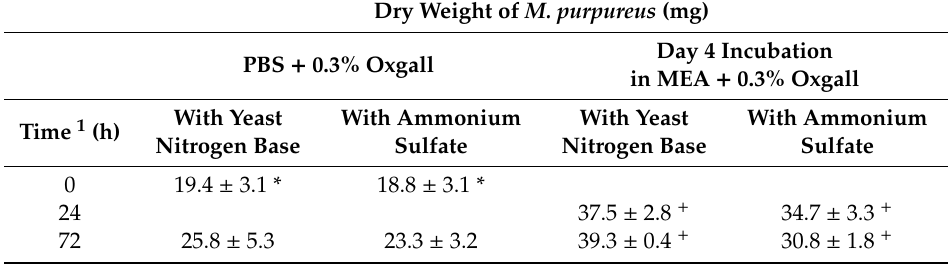
Table 5. Dry weight (mg) of M. purpureus CBS 109.07 after incubation in PBS with 120 µ g / mL cholesterol and 0.3% ( w / v ) oxgall bile salts and rescued in MEA with 0.3% ( w / v ) oxgall bile salts. M. purpureus is washed in PBS + 0.3% oxgall and then transferred to MEA with 0.3% oxgall, and sample collected after 4 days. Two independent trials, corresponding to samples used in PBS cholesterol assimilation, were conducted for each growth phase at each time point. Standard deviation in cholesterol content is absolute